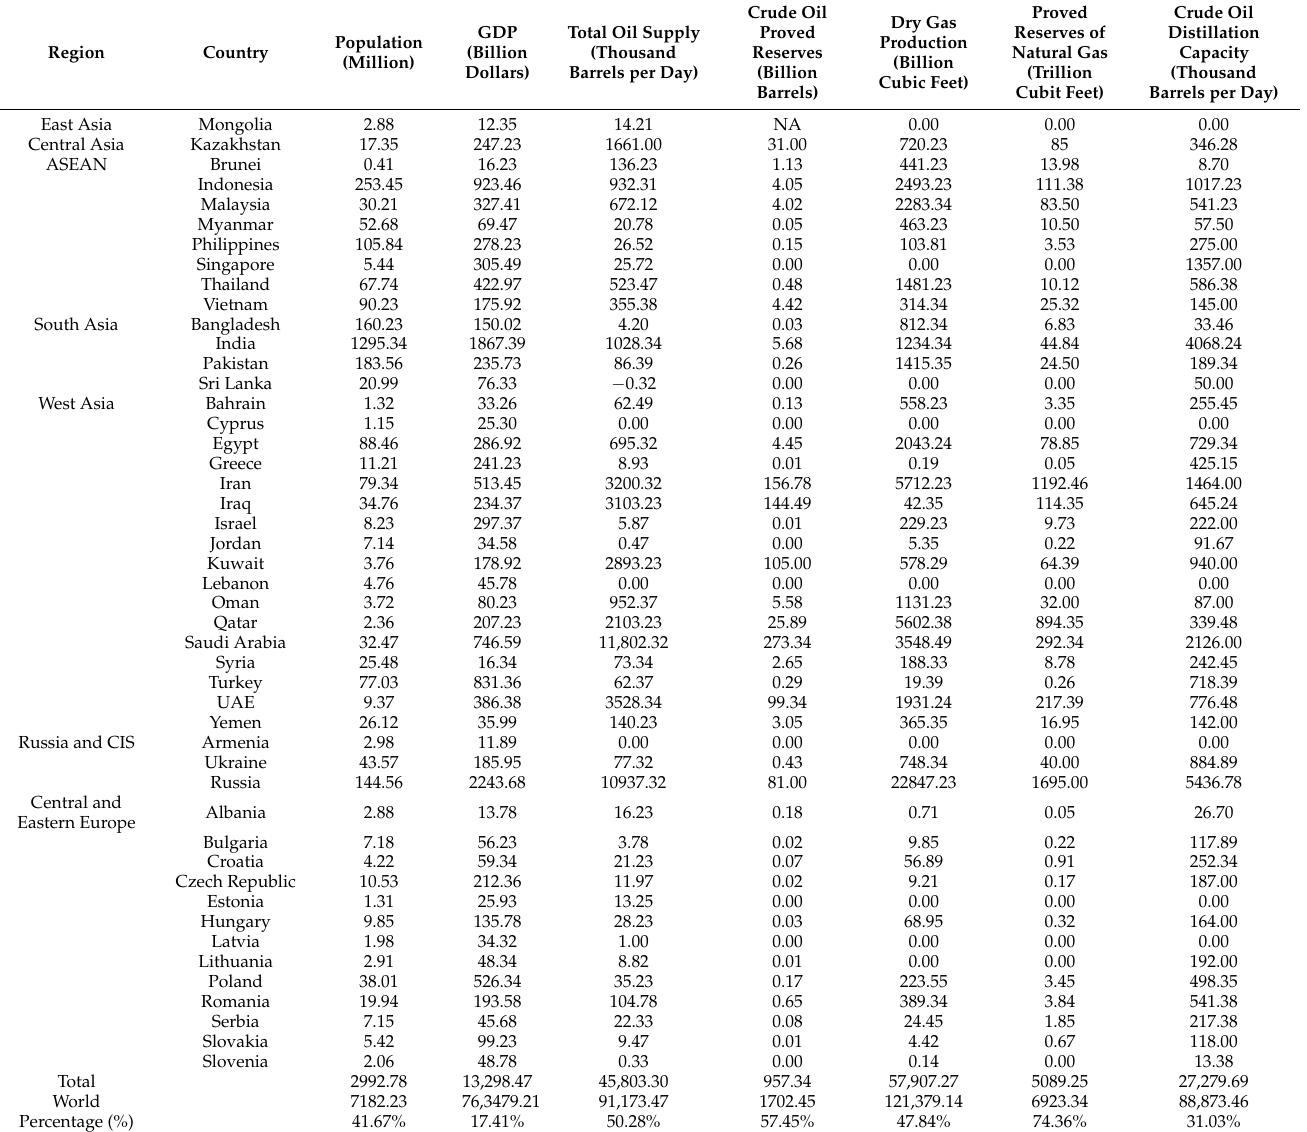
Table A2. Main statistics of 50 Nations alongside the China’s “Belt & Road Initiative in 2014”.